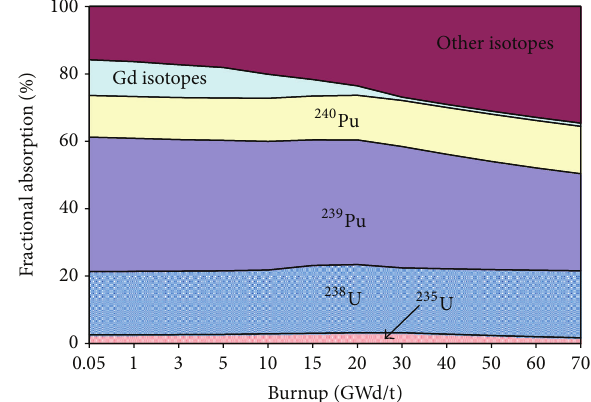
Figure 9: Fractional neutrons absorption in MOX fuel.